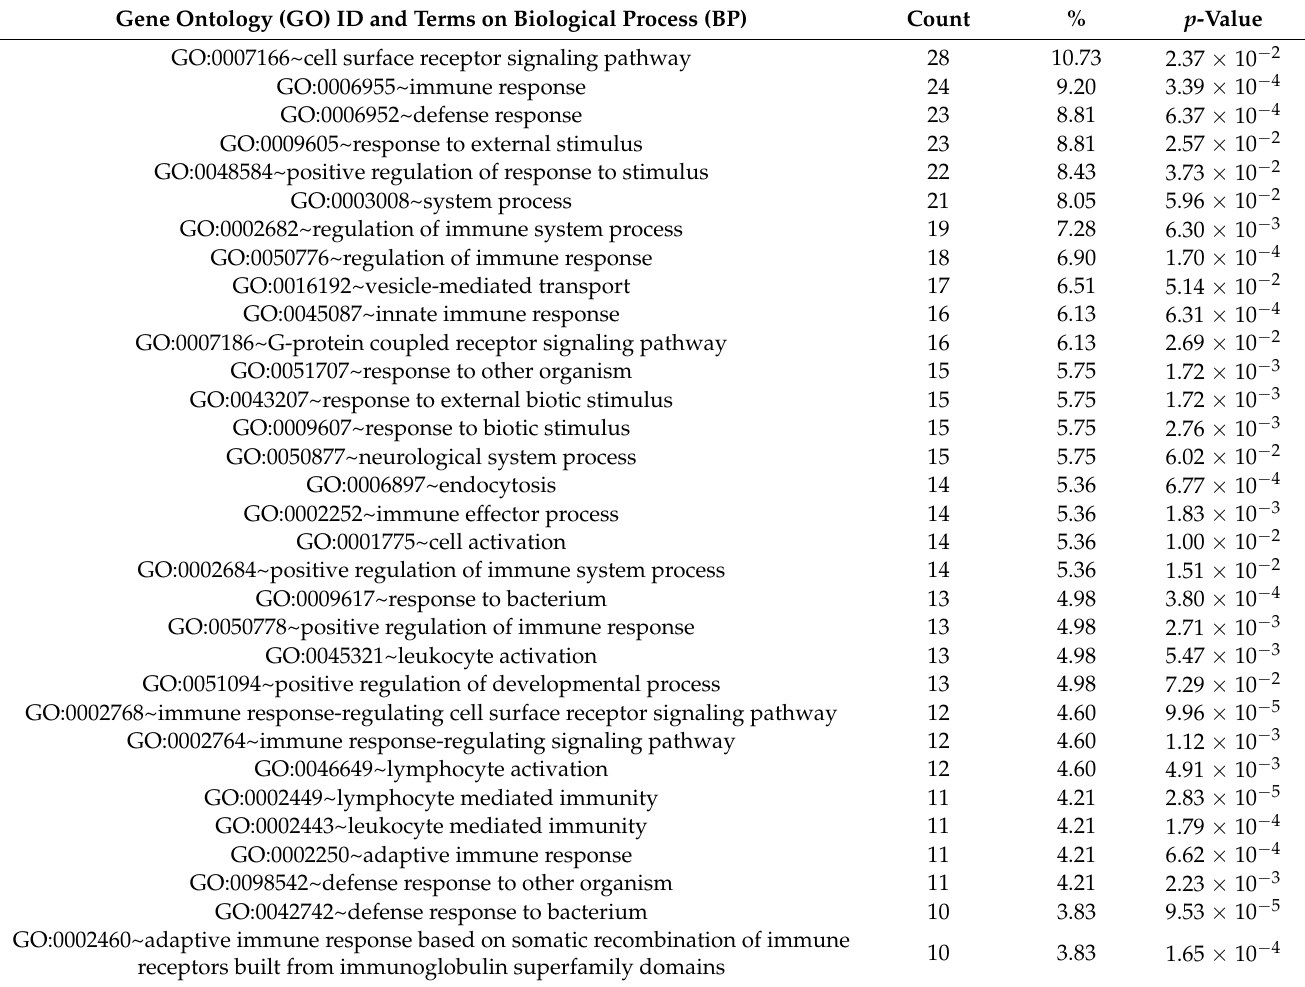
Table 7. The functional analysis of the upregulated genes at 12 h after LLL